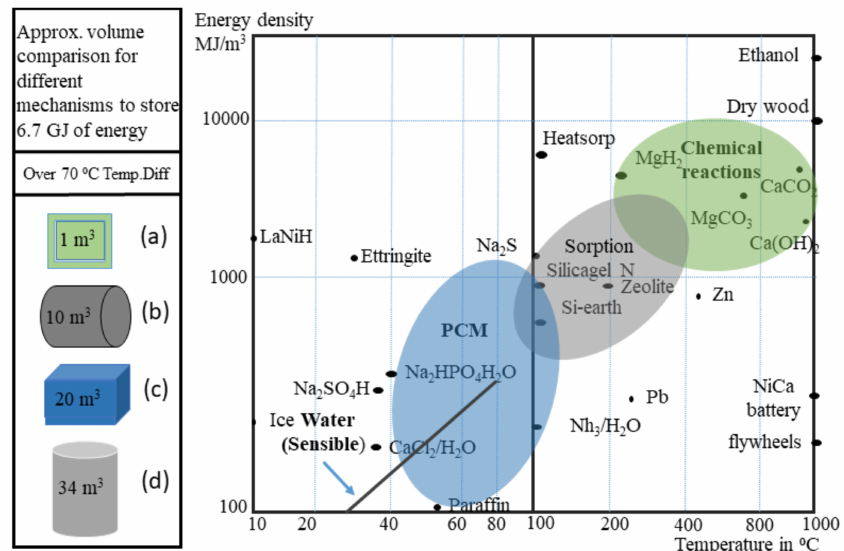
Figure 2. Energy densities of different thermal storage systems [30]: ( a ) Chemical reaction TES;